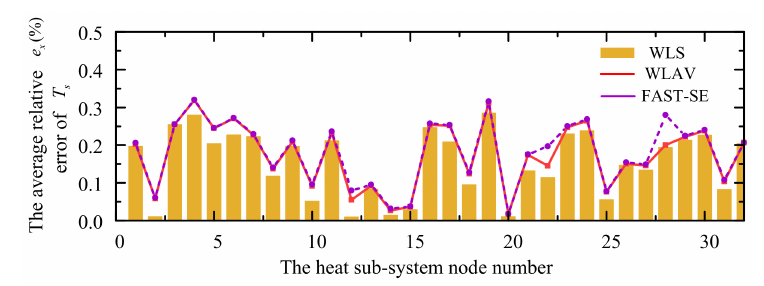
Figure 7. The average relative error e x ( % ) of m .